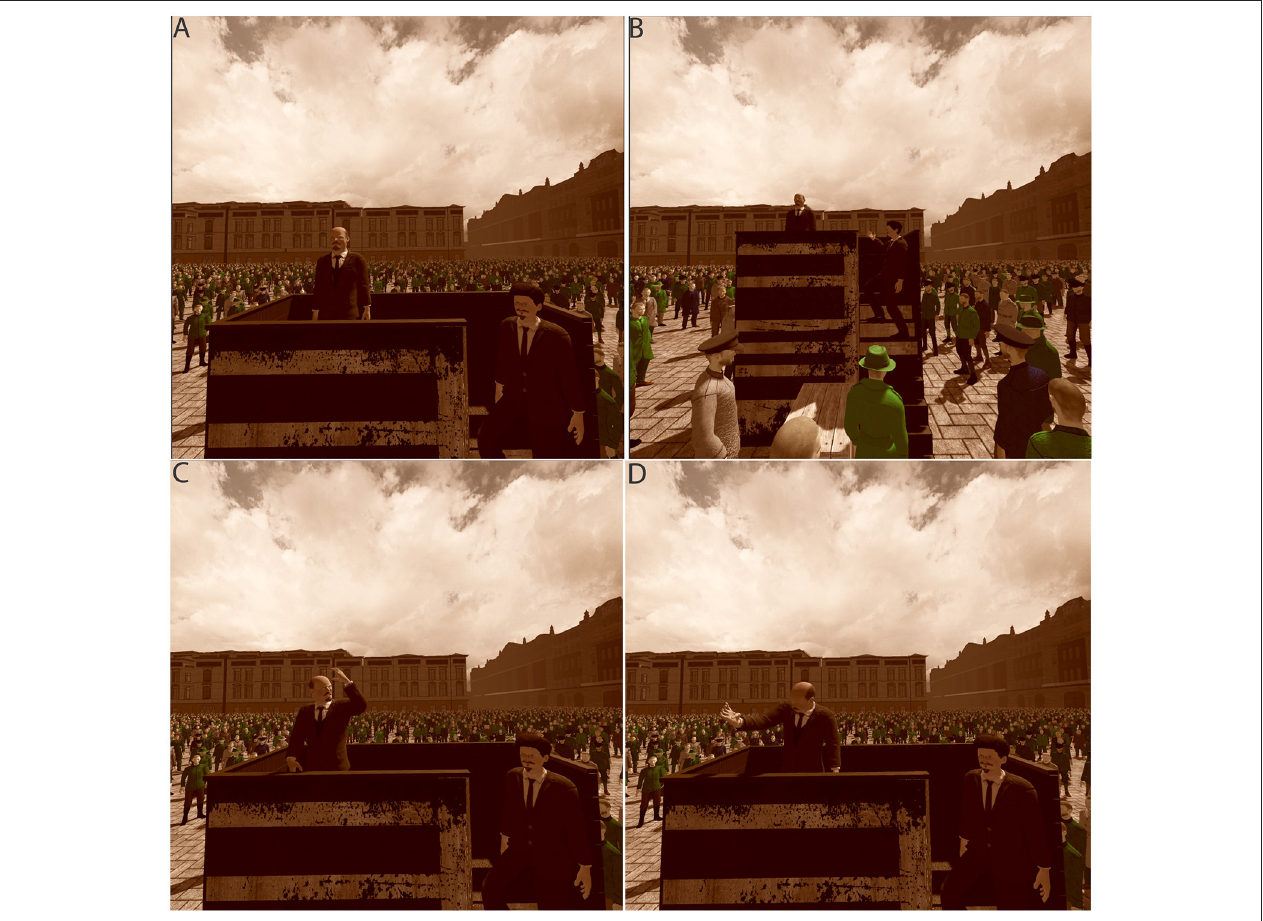
FIGURE 1 | Views from the crowd Sverdlov Square Moscow (A) Lenin waiting before starting the speech (B) Trotksy signals to start the speech (C) and (D) Lenin giving the speech. The scene was rendered with a sepia color to make it seem old. The images here were recorded by screen capture, and have been slightly brightened, since in the HMD they look brighter than the screen